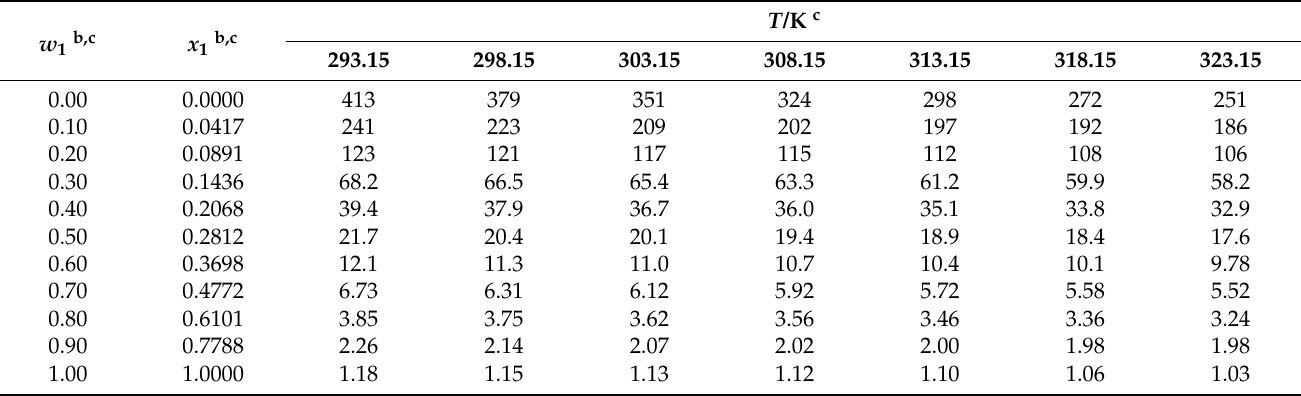
Table 4. Activity coefficients of benzoic acid ( γ 3 ) in {ethanol (1) + water (2)} mixtures at several temperatures and p = 90 kPa.